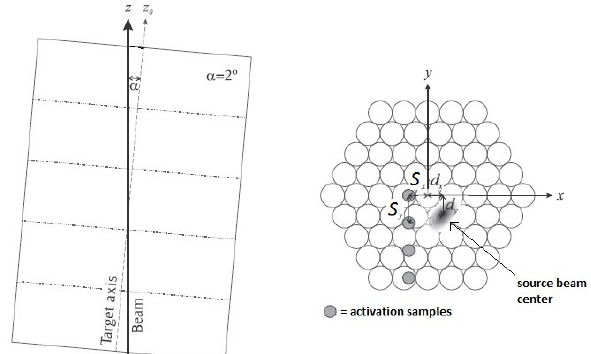
Figure 2. The 2-degree QUINTA rotation from the source beam axis (top QUINTA view, left) and shift of the primary beam centre depending on beam settings (front QUINTA view, right). The symbol α represents the deviation between the beam axis z and target axis z 0 . S x and S y are the coordinates of an activation sample position on the horizontal axis x and vertical axis y. d x and d y are coordinates of the beam centre on the x and y axes. The rotation is mostly made because of the maximal use of the source beam [16, 23] Table 1. Beam characteristics of the UA and CC experiments at the beam entrance into QUINTA. d x and d y are coordinates of the beam centre position and FWHM x and FWHM y are full energy widths at half maximum of the 2D beam Gaussian profile